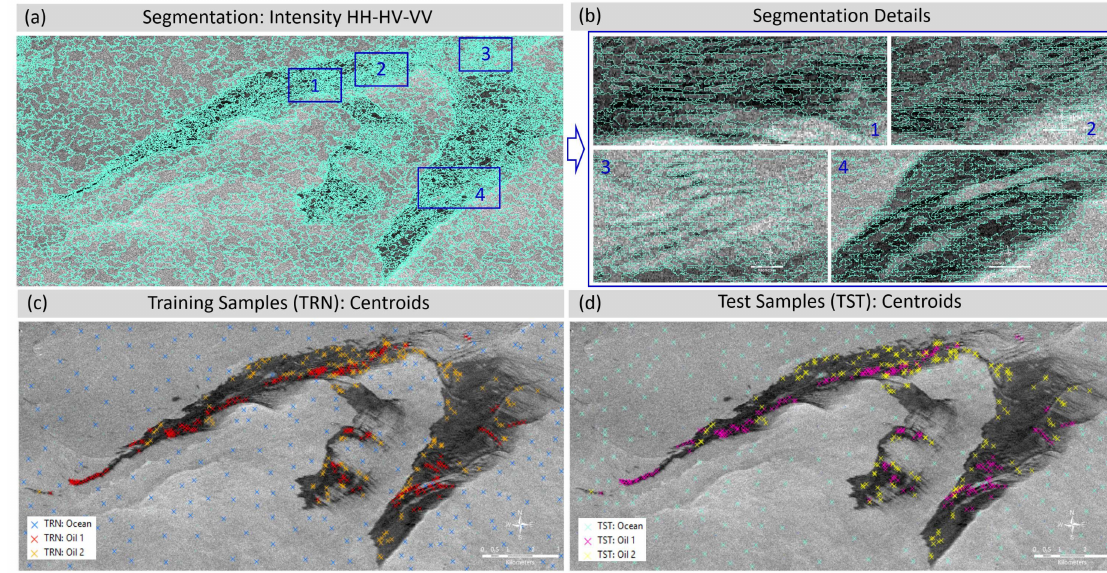
Figure 4. ( a ) Multiresolution Segmentation, ( b ) details about dark spots detection, and ( c , d ) Centroids position of the training ( c ) and test ( d )